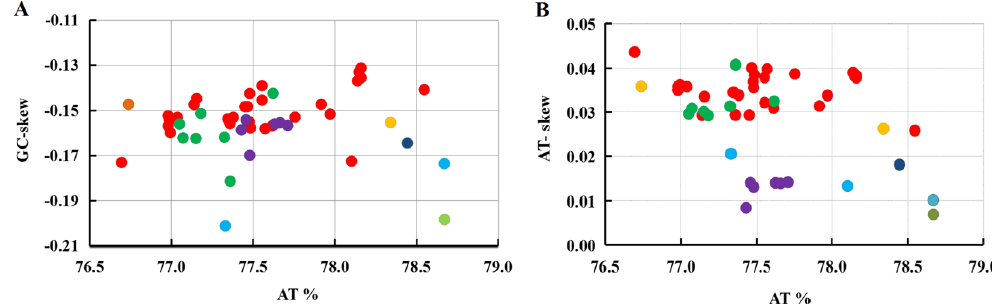
Figure 2. Comparative analysis of AT content, AT- and GC-skew in 50 mosquito mitogenomes. Red, orange, green, light blue, purple, blue and light green dots represent mitogenomes from the subgenus Cellia , Anopheles , Nyssorhynchus , Aedes , Culex , Kertezia and Armigeres , respectively.